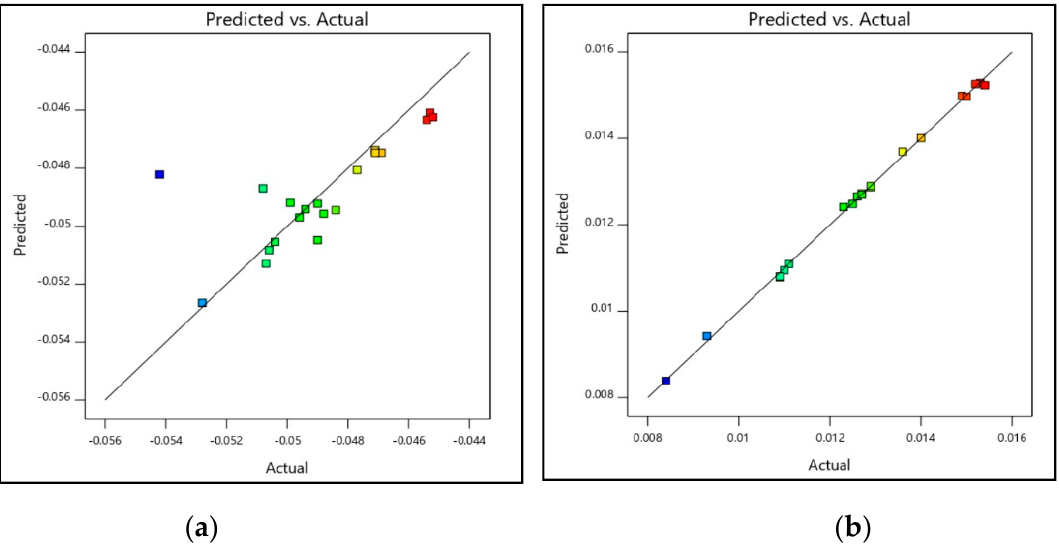
Figure 9. Predicted vs. actual for single story housing for two types of concrete: ( a ) fly ash, ( b ) blast furnace slag.